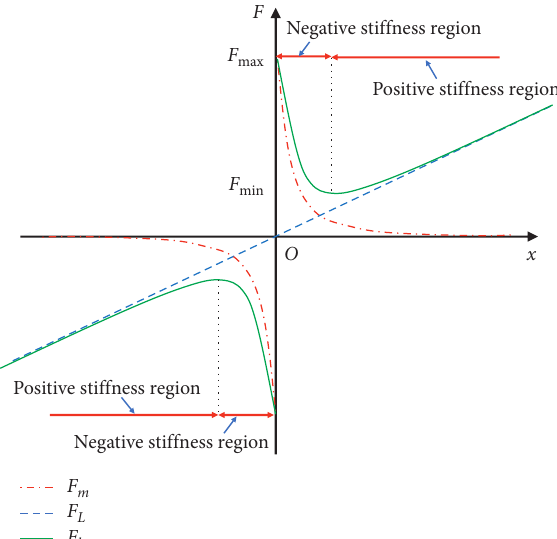
Figure 2: The equivalent force-displacement curve of (F)